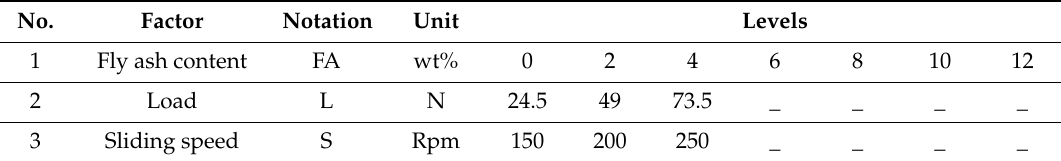
Table 3. Levels of factors.